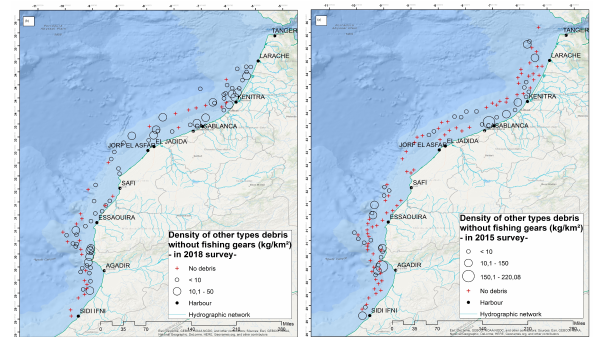
Figure 10. The spatial distribution of fishing related debris in the seafloor of the North and the Central part of the Moroccan Atlantic in both surveys: (a) :2015, (b):